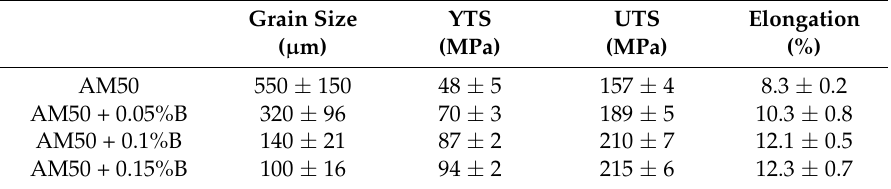
Table 2. The grain size and mechanical properties of AM50 + xB (x = 0, 0.05, 0.10, 0.15, wt.%).